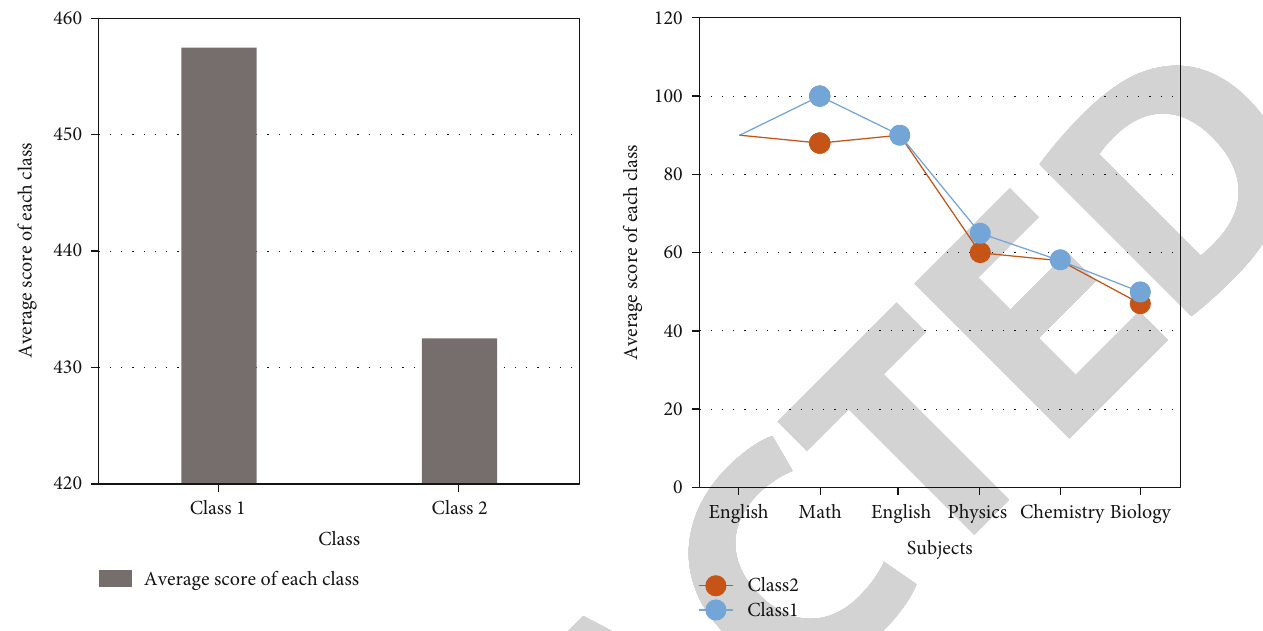
Figure 10: The average scores of the whole class and the subjects in the fi nal exam of senior